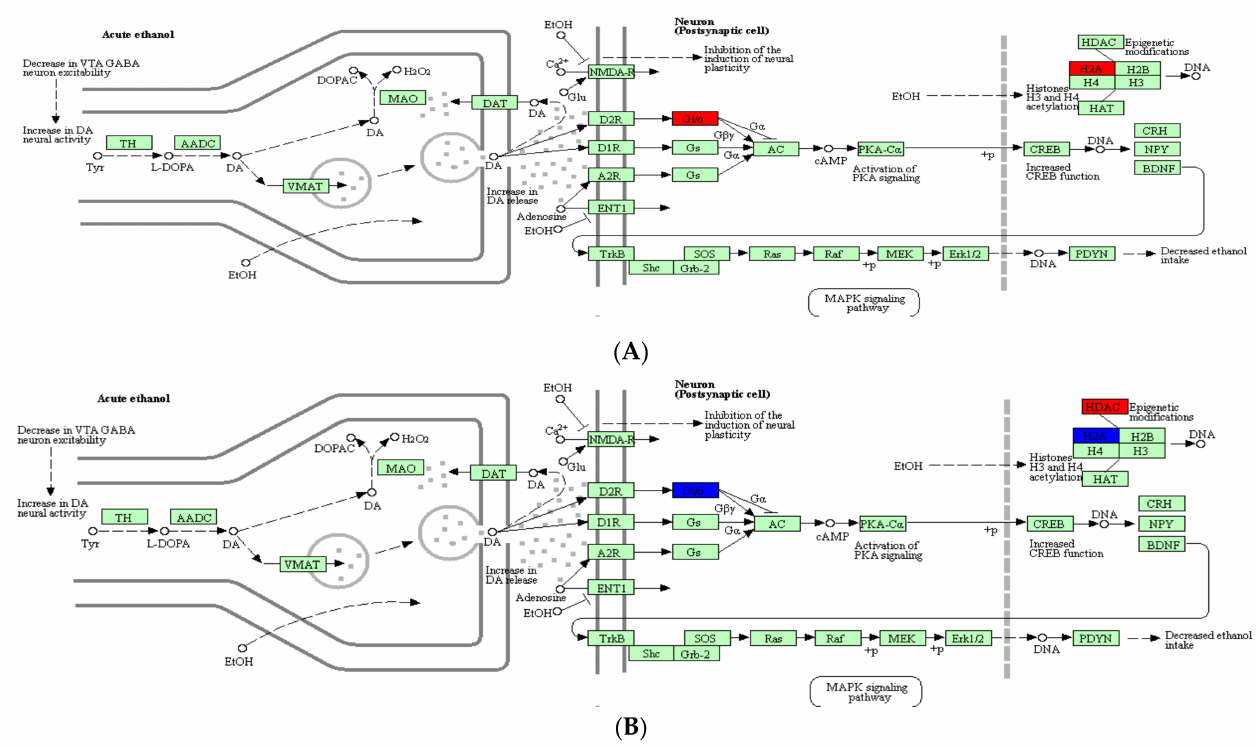
Figure 4. KEGG analysis of alcoholism pathway in ethanol and flavonoids groups. ( A ) Ethanol group versus control group; ( B ) flavonoids group versus ethanol